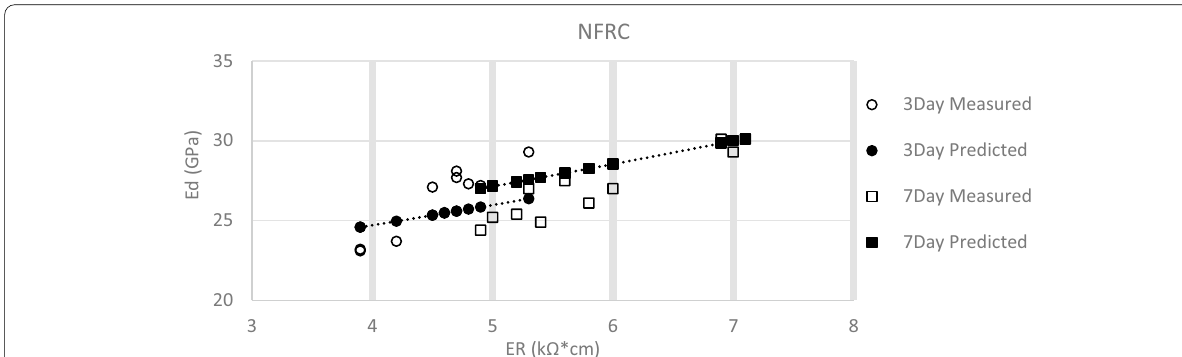
Fig. 5 Correlation between dynamic modulus and electrical resistivity for NFRC.